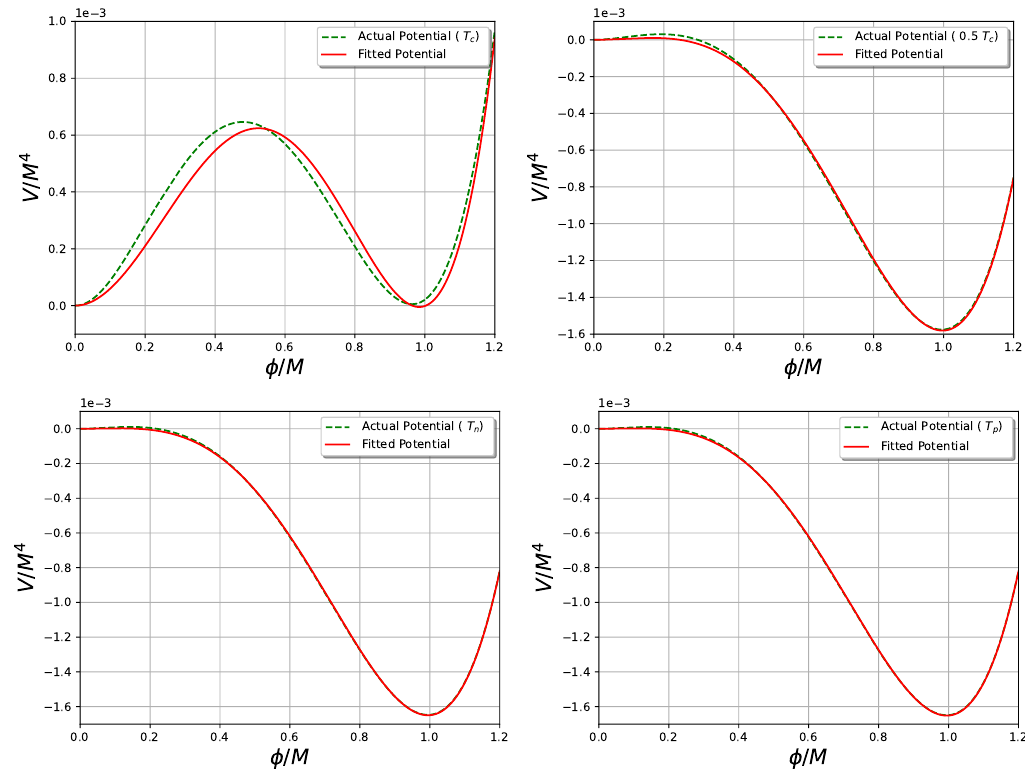
Figure 8 . Comparison between the actual thermal potential and the fit at different temperatures.